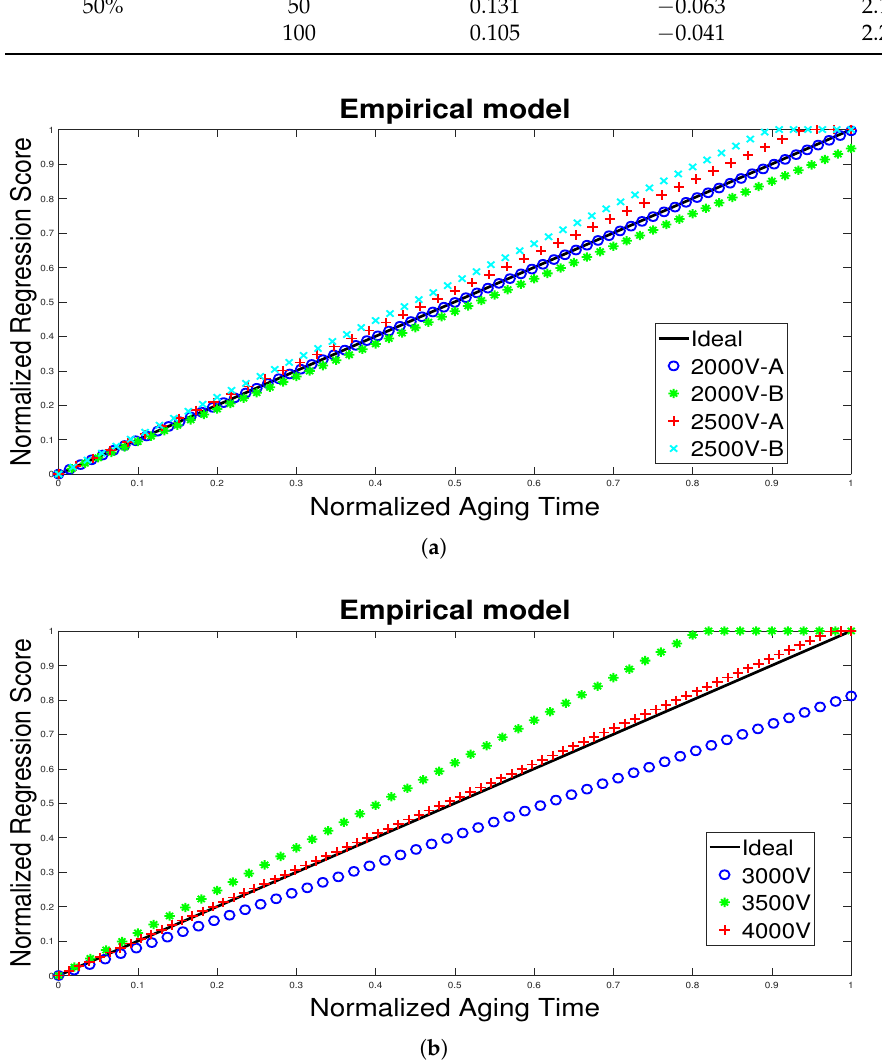
Figure 9. Empirical model with 50% of time window length with a power supply in the range [ 2000 2500 ] V ( a ) and in the range [ 3000 4000 ] V ( b